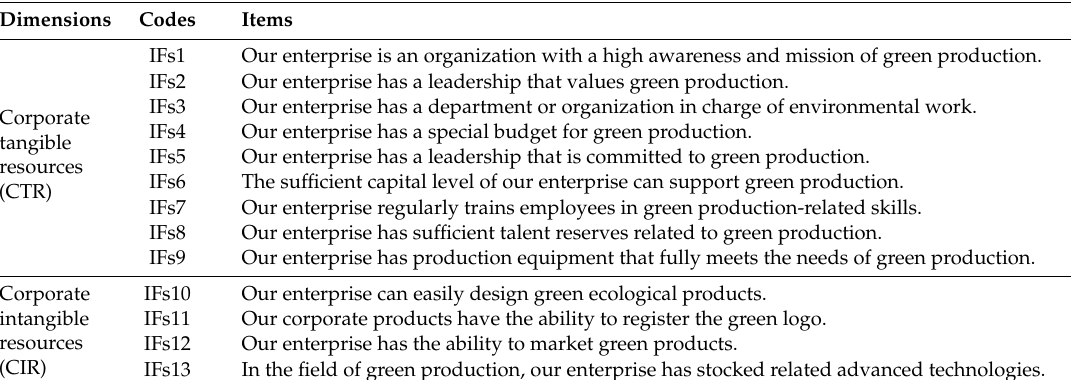
Table A1. Questionnaire items on the internal factors (IFs)